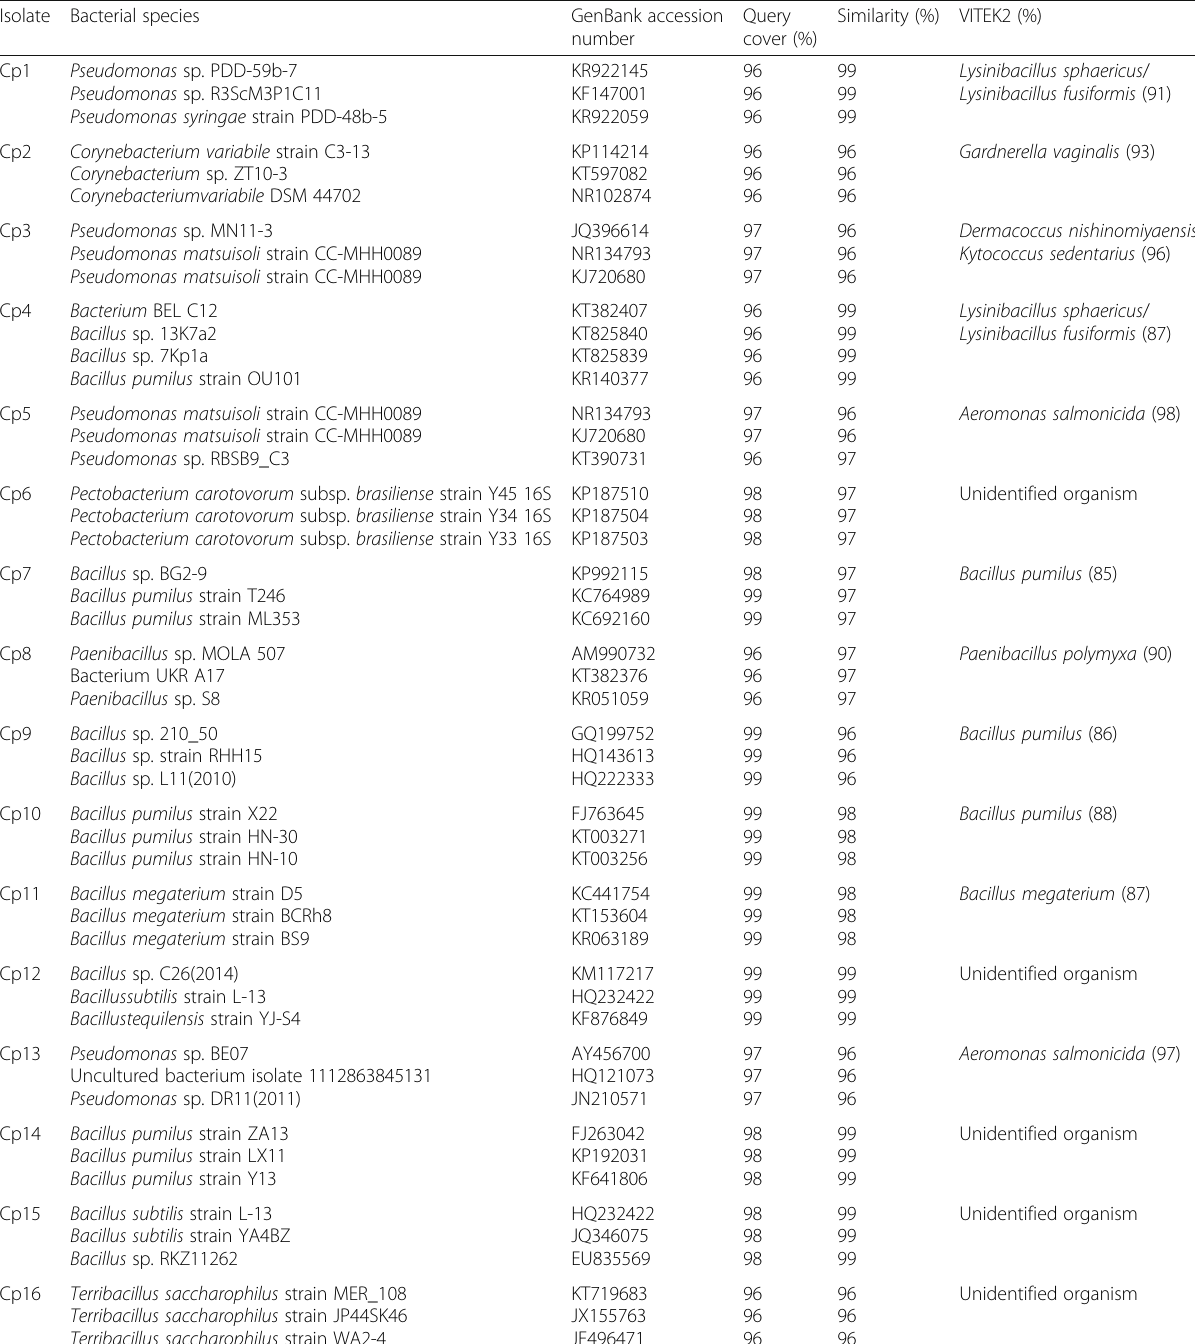
Table 3 Percent similarity of the bacterial isolates with their closely related species based on the BLAST searches in NCBI GanBank database (Altschul et al. 1990) Isolate Bacterial